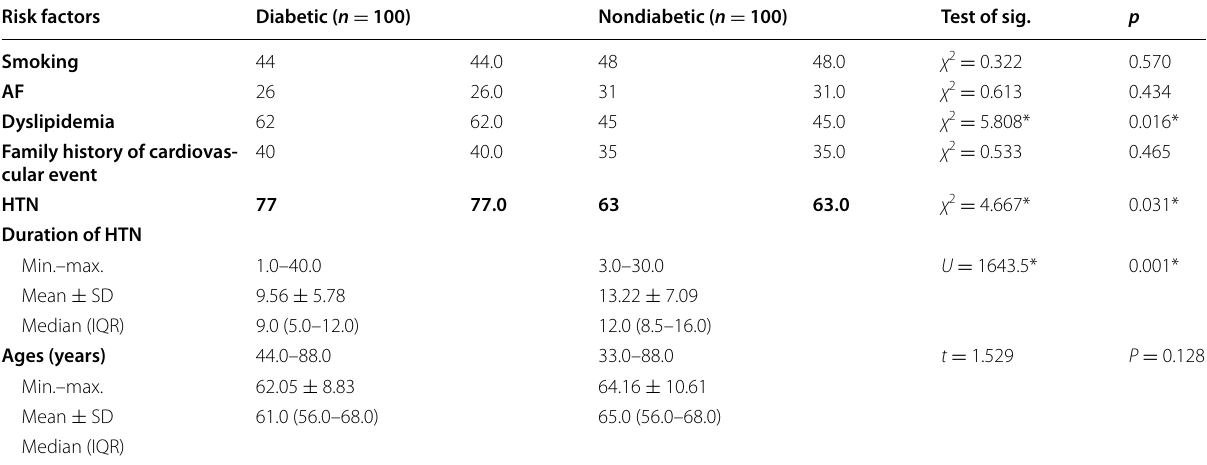
Table 2 Baseline characteristics for the studied cohort Risk